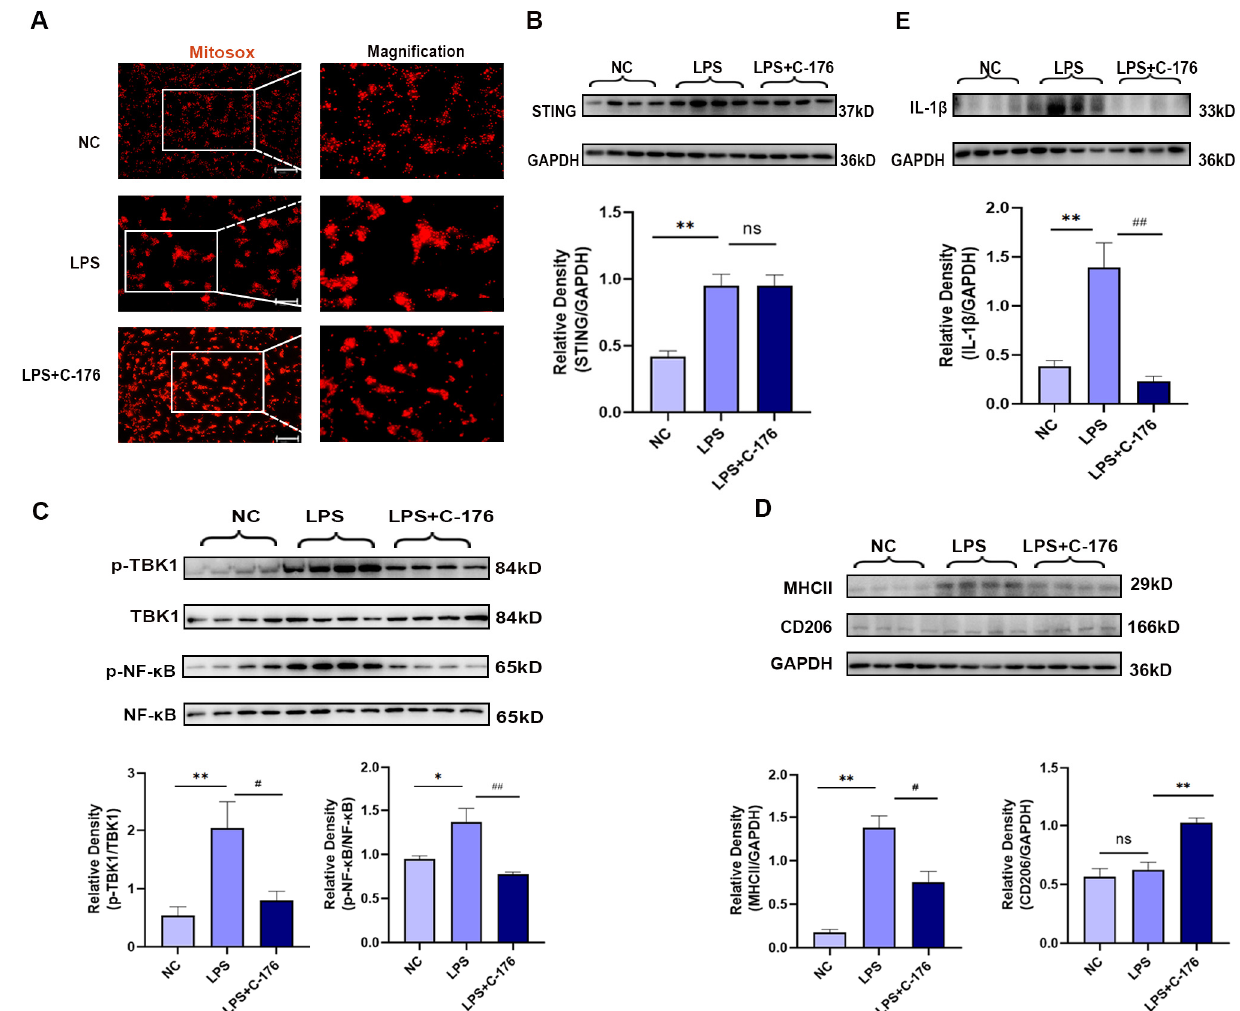
Figure 5. C-176 alleviated LPS-induced polarization of M1 microglia in vitro. ( A ) Representative images of MitoSox-staining in GMI-R1 cells treated with LPS (1 µ g/mL) or LPS (1 µ g/mL) + C-176 (20 µ M). The right panel shows magnification. ( B – E ) The protein expression levels in GMI-R1 cells, treated with LPS (1 µg/mL) or LPS (1 µg/mL) + C-176 (20 µM), were assessed using Western blot and quantified: STING ( B ); p-TBK1/TBK1 and p-NF- κ B/NF- κ B ( C ); MHCII and CD206 ( D ); IL-1 β ( E ). GAPDH was detected as internal control. NC, negative control. Data are expressed as mean ± S.E.M., n = 4, * p < 0.05, ** p < 0.01 vs. NC; # p < 0.05, ## p < 0.01 vs. LPS. Scale bar = 50 µm. Full pictures of the Western blots are presented in Supplementary Materials. 4. Discussion The present study demonstrated that STING in the mPFC might be a crucial regulator in promoting microglia polarization to the M1 phenotype after CIBP. We found STING was upregulated in the mPFC after CIBP, accompanied by the increased phosphorylation